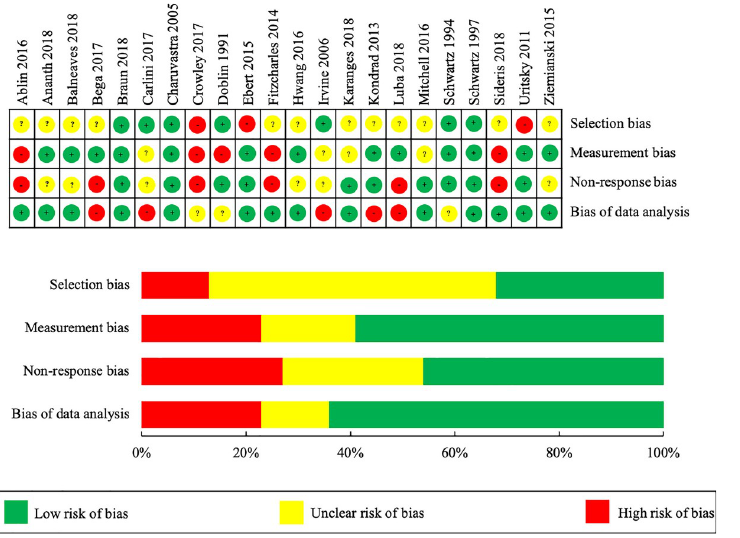
Fig 2. Risk of bias summary and graph–quantitative studies.